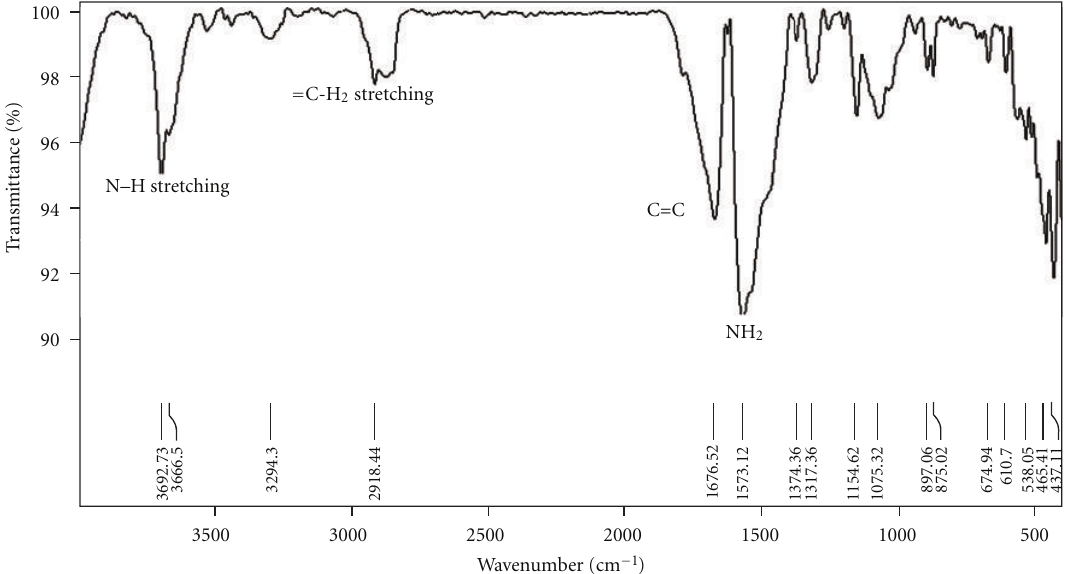
Figure 4: FTIR spectra of N-doped mesoporous titania.